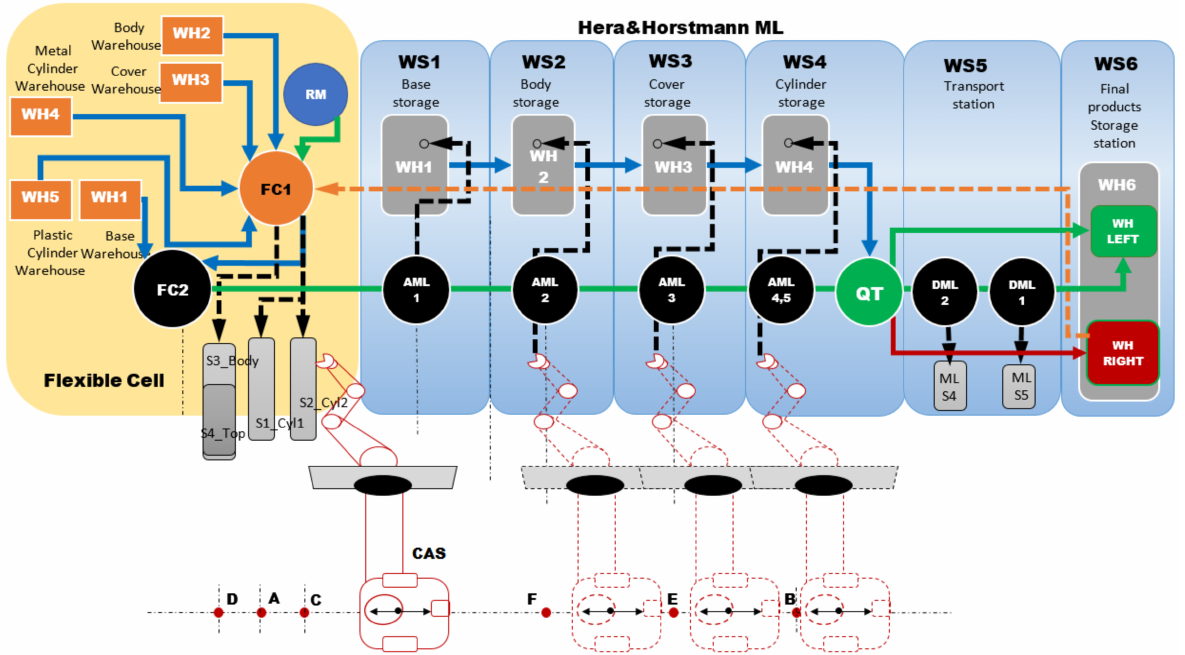
Figure 8. A/D/RML assisted by